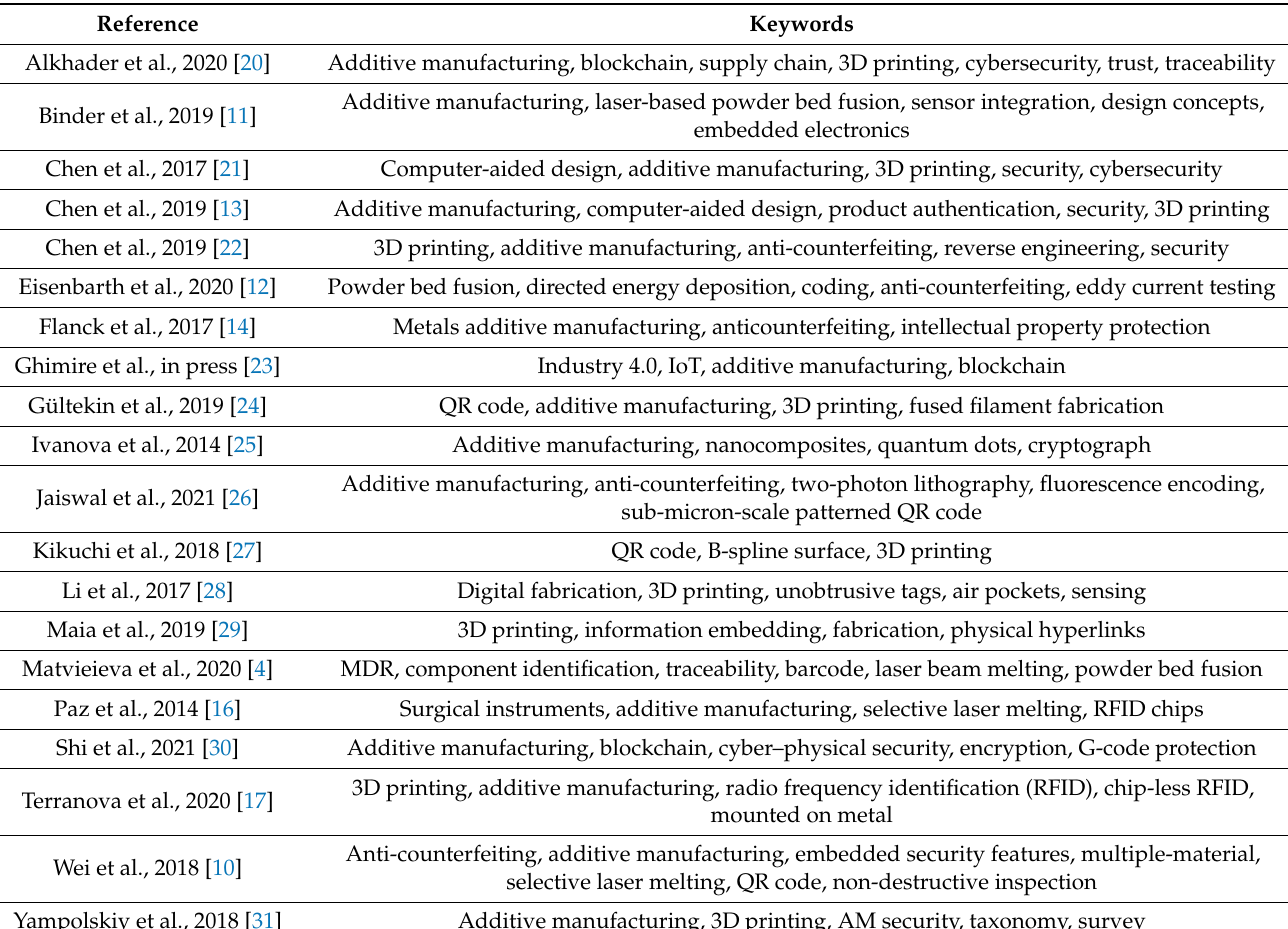
Table 1. Examples of keywords used in published papers regarding traceability of AM parts [4,10–14,16,17,20–31]. Keywords are listed exactly as they appear in the original